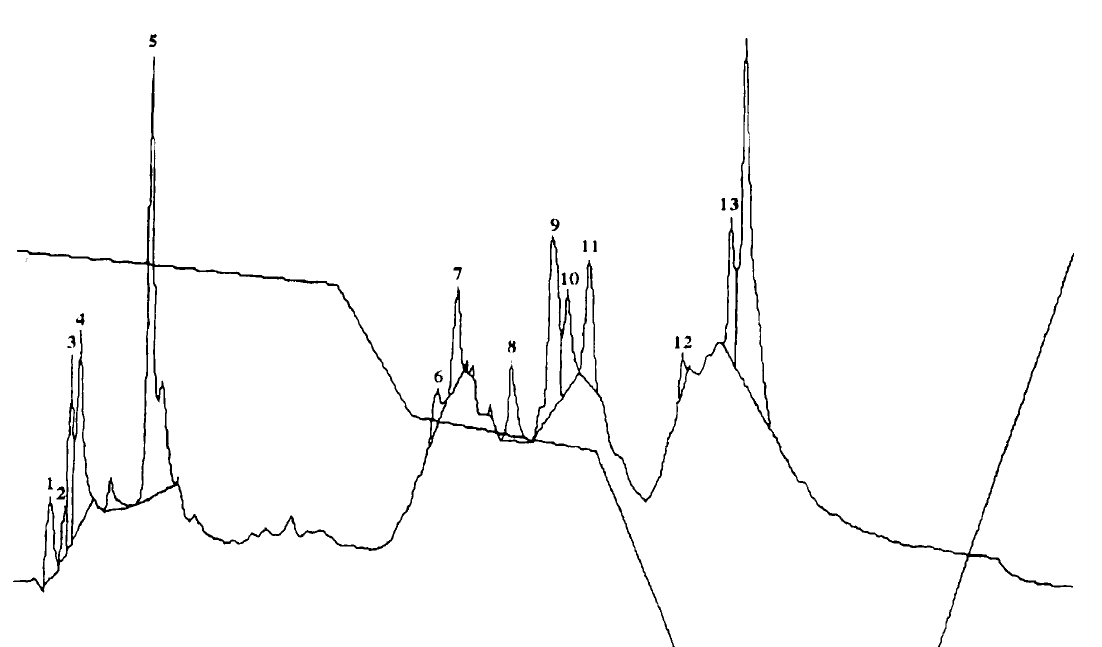
Figure 3. Chromatogram of alfalfa leaf-derived saponins. Peak 8: 3-GlcA, 28 AraRhaXyl medicagenic acid; peak 9: 3-GlcA, 28 AraRha medicagenic acid; and peak 11: Soyasaponin I.